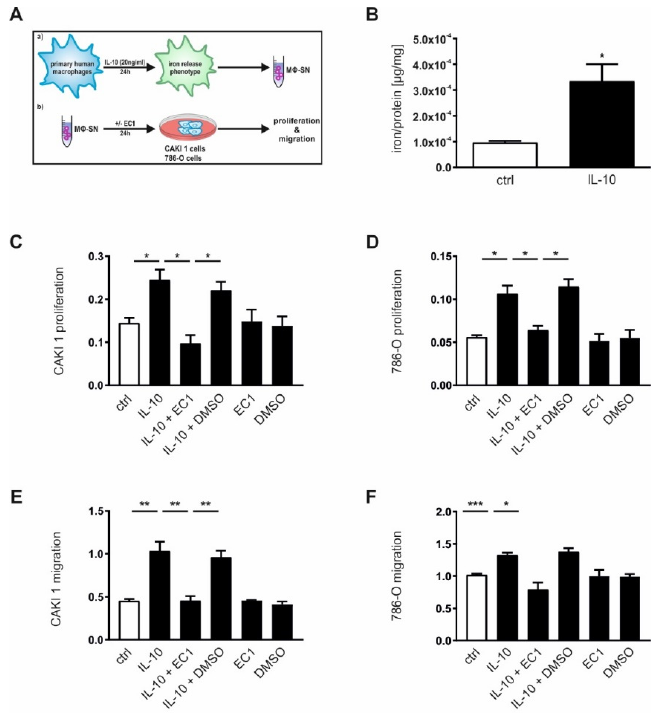
Figure 5. Macrophage-secreted iron induces proliferation and migration of tumor cells in vitro. ( A ) Schematic overview of how to generate conditioned medium from iron-releasing human M Φ . ( B ) Iron amount measured by AAS relative to the total protein amount in the supernatant of primary human M Φ , either left untreated (ctrl) or stimulated with IL-10 (20 ng/ml; 24 h) ( n = 5). Proliferation of ( C ) CAKI 1 ( n = 4) and (D) 786-O ( n = 4) cells as well as migration of (E) CAKI 1 ( n = 4) and ( F ) 786-O cells ( n = 4) upon stimulation with the supernatant of IL-10-stimulated M Φ in the presence or absence of an extracellular chelator (EC1, 100 µM) or dimethyl sulfoxide (DMSO) as negative control measured with the xCELLigence system. Graphs are displayed as means ± SEM with * p < 0.05, ** p < 0.01, *** p < 0.001.